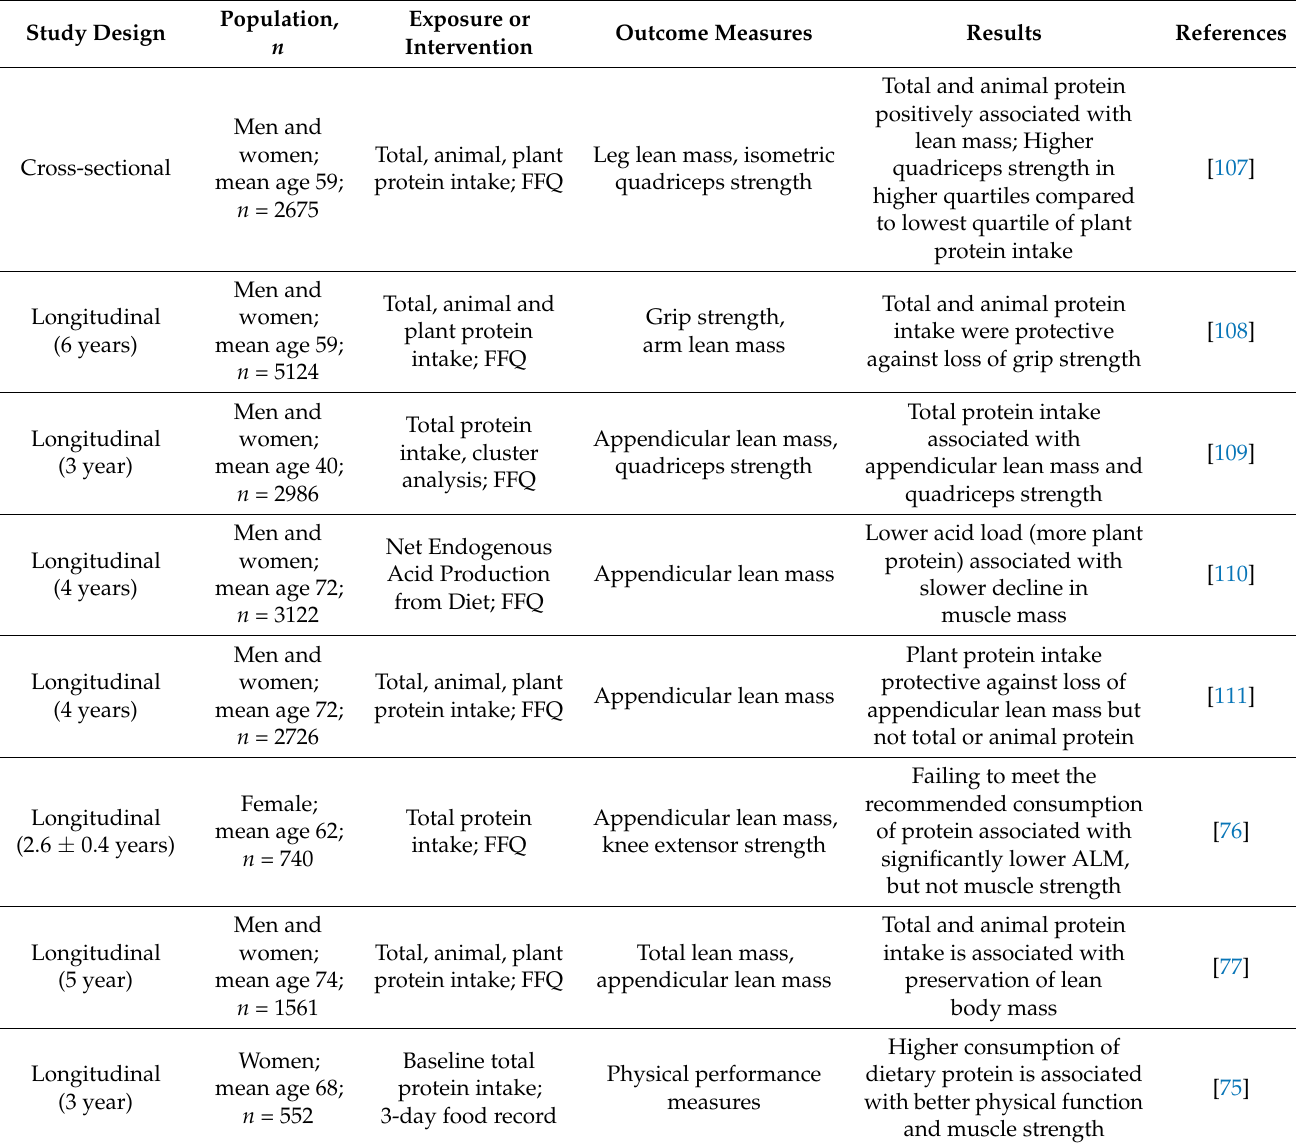
FFQ, Food Frequency Questionnaire; ALM, Appendicular Lean